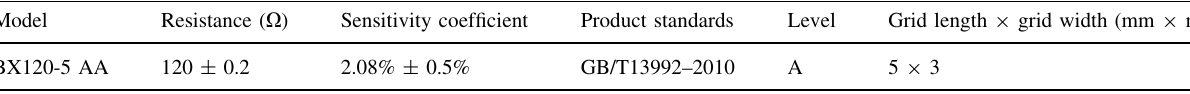
Table 3 Specifications of strain gauges used in experiment Model